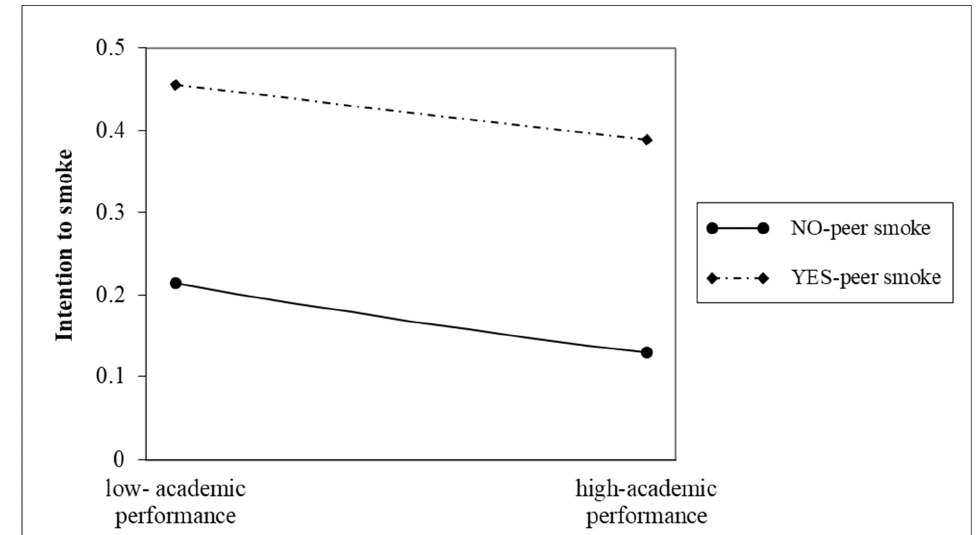
Figure 1. Interaction between academic performance and peer smoke and smoking intentions among non-smoking students.